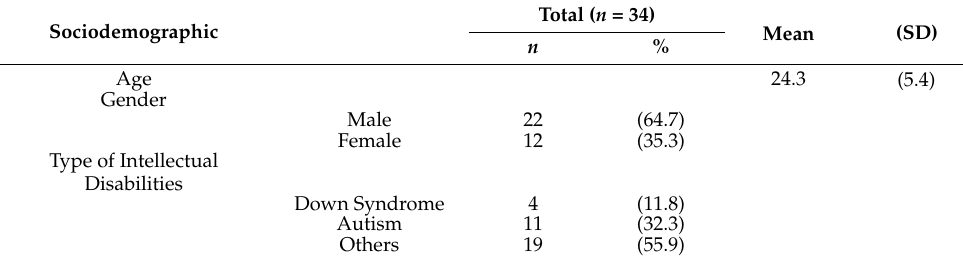
Table 1. Sociodemographic of participants ( n =